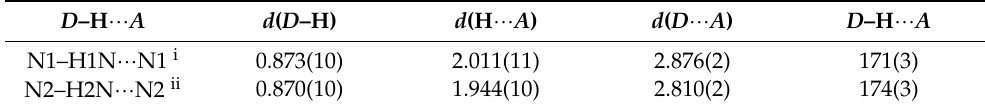
Table 2. Hydrogen-bond geometry (Å, ◦ ).